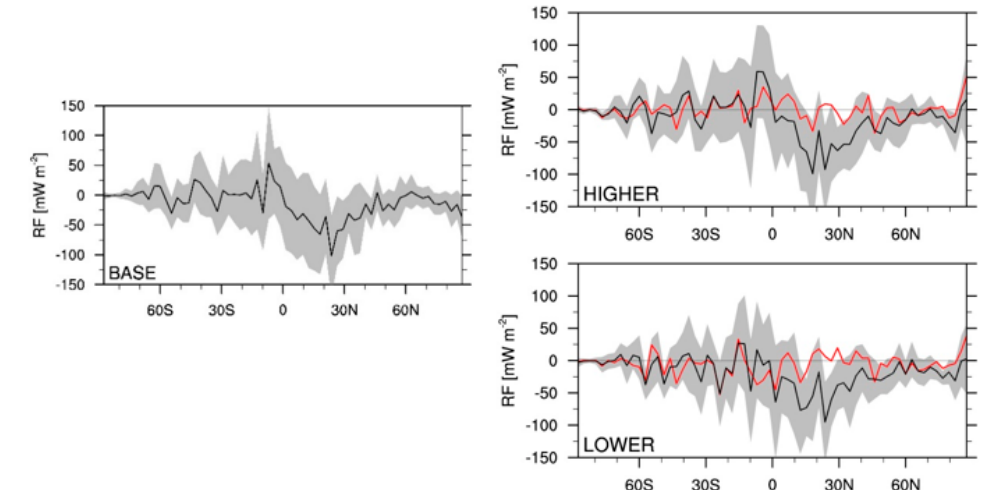
Figure 6. Zonal mean radiative forcing (black line) of indirect aerosol (warm) cloud effect from EMAC/MADE for the reference ( left ) and for inventories ‘Flying higher’ ( top right ) and ‘Flying lower’ ( bottom right ). The change between reference and scenarios is highlighted (red line). The shaded regions depict the 95% confidence interval. Radiative forcing is calculated as the difference between two distinct simulations, one with and one without aircraft emissions.